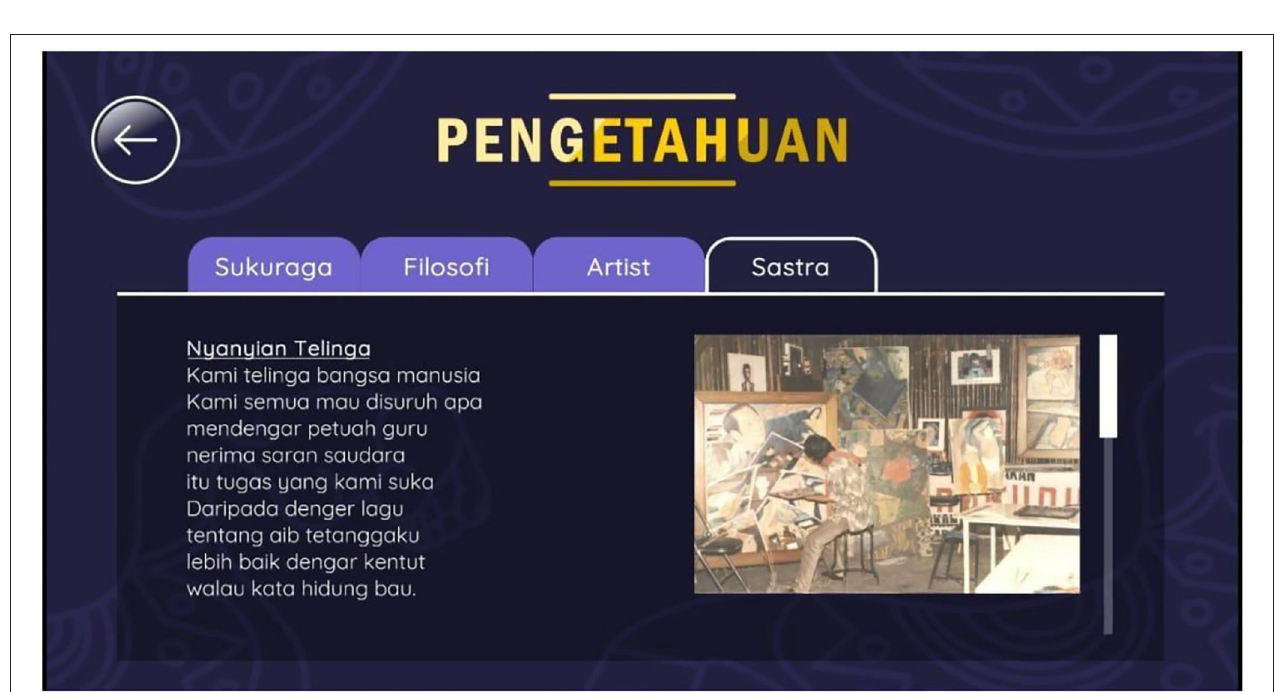
FIGURE 5 | Ceu Eli’s character in the Sukuraga Puppet application character features.